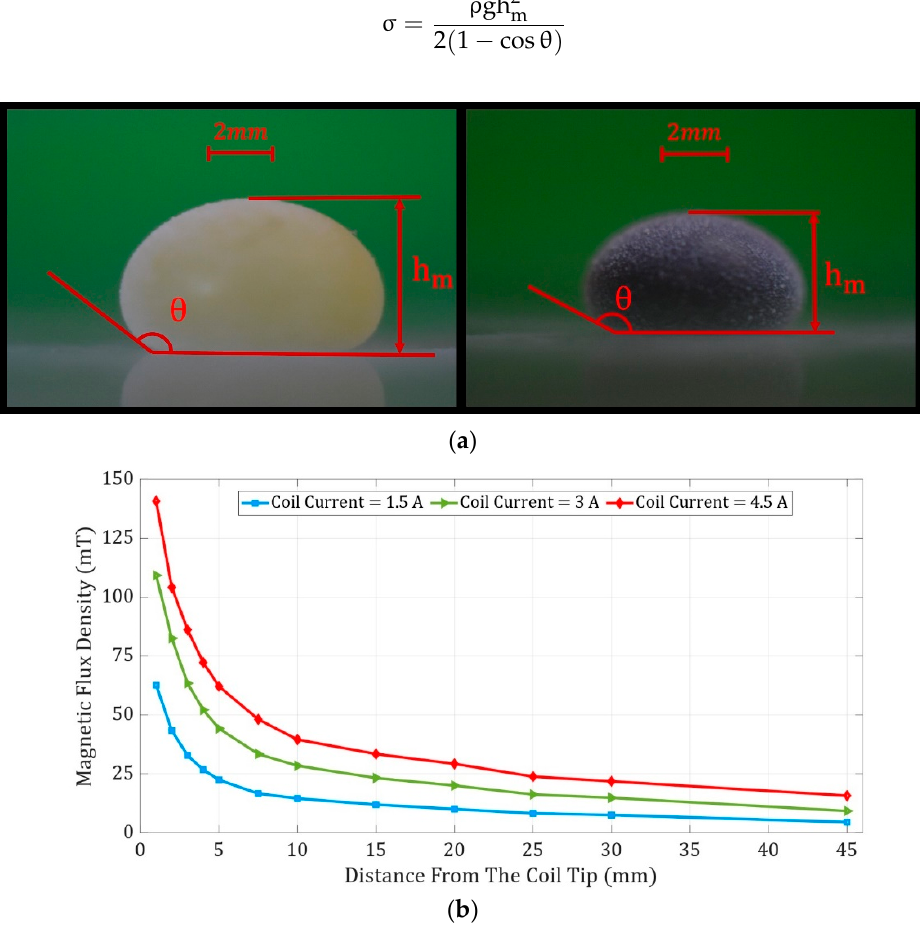
Figure 2. ( a ) Sideview of the WLM and FLM with volumes of 150 µ L and 250 µ L, respectively. ( b ) The magnetic flux density versus the horizontal distance from the coil tip for coil currents of 1.5 A, 3.0 A, and 4.5 A. The vertical distance between the top of the coil and the plane on which FLMs were placed is fixed at 3